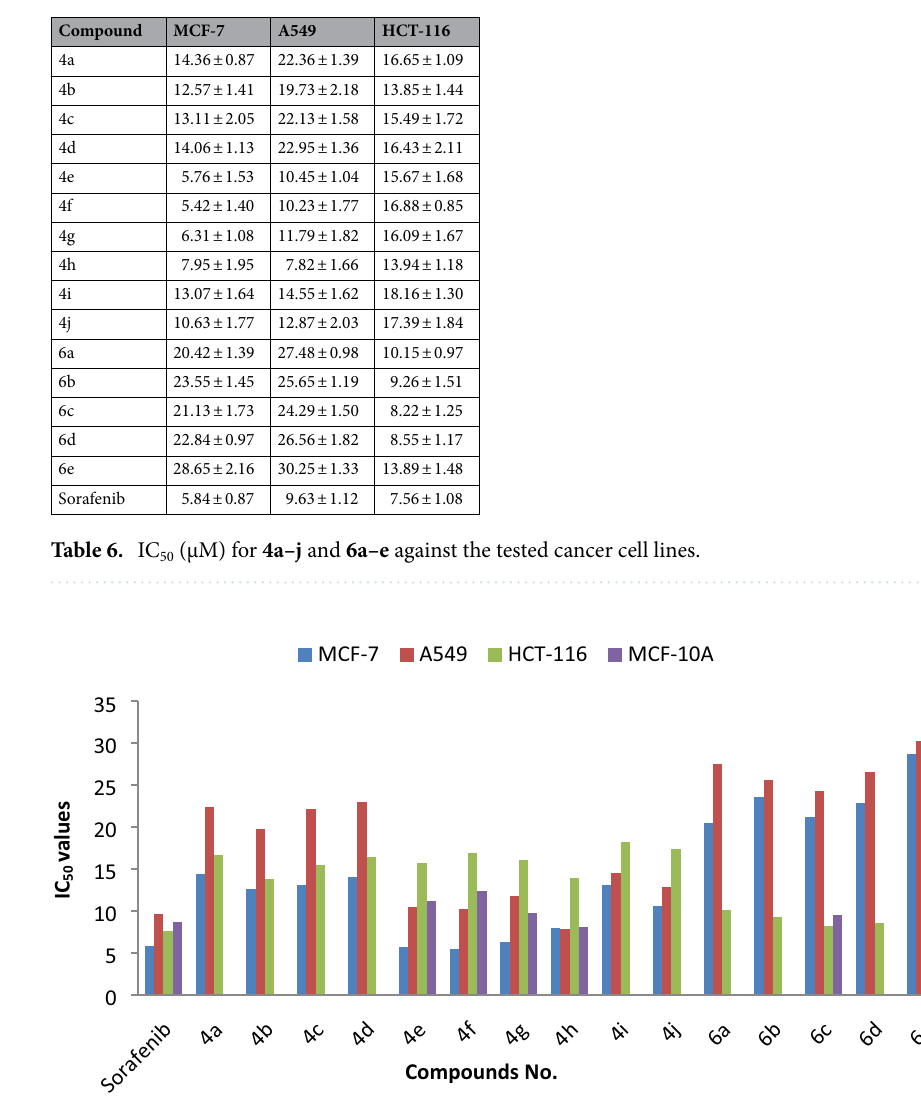
Figure 6. IC 50 (μM) of 4a–j and 6a–e against the tested cancer cell